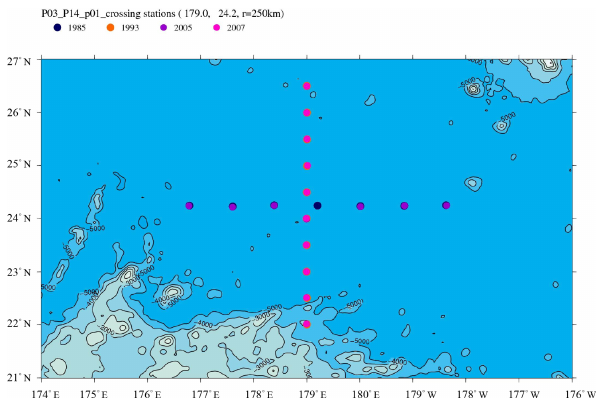
Figure 5. Example of crossover stations for comparison at P03–P14 crossover.